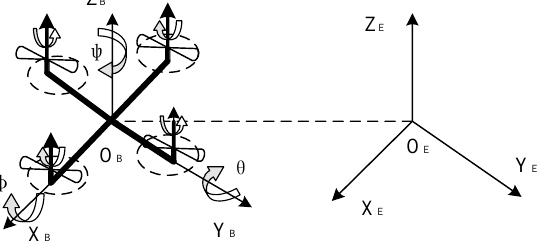
Figure 2. Structure and coordinate transformation of quadrotor UAV.